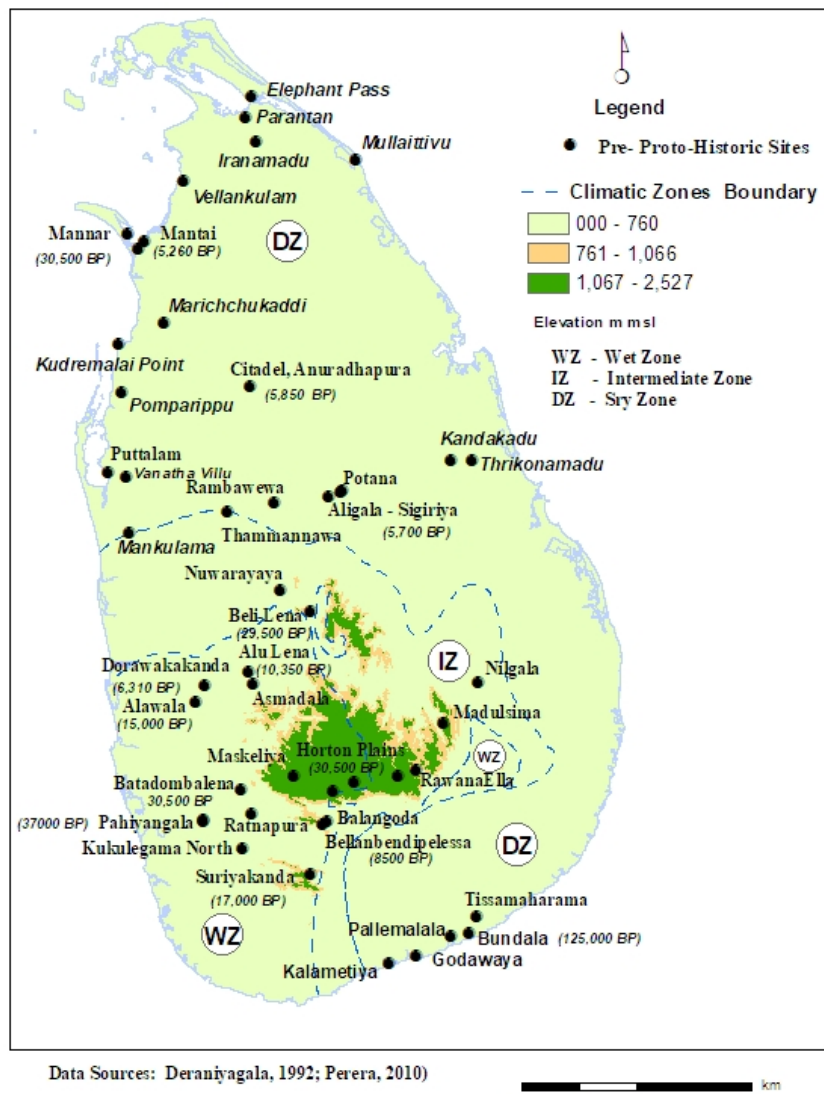
Figure 3: Pre- and Proto-historic habitation sites of Sri